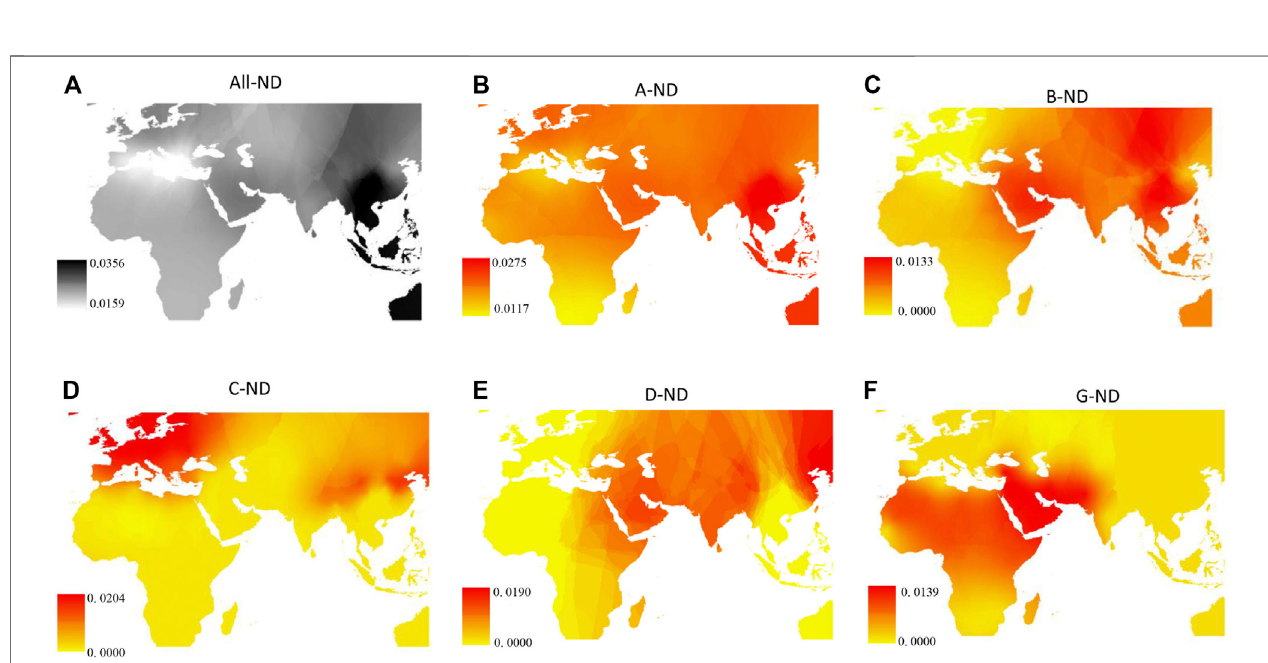
FIGURE 2 | Synthetic maps illustrating the geographic variation of nucleotide variability for the total lineages and goat mtDNA lineages. (A) Total lineages; (B) – (F) lineage A, lineage B, lineage C, lineage D, and lineage G, respectively.